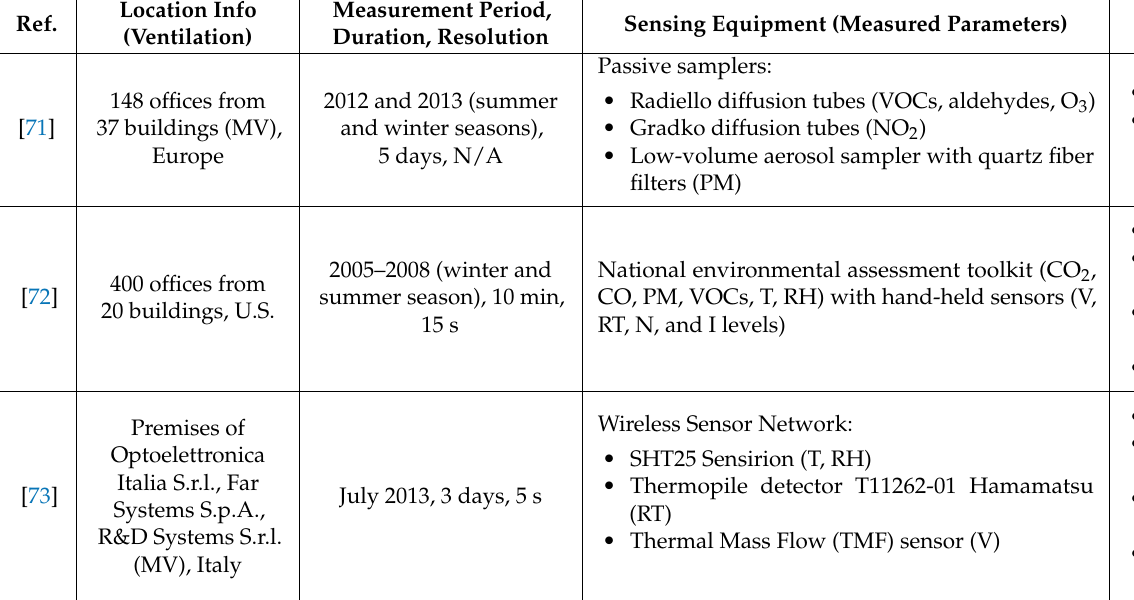
Table A4. Field measurement studies